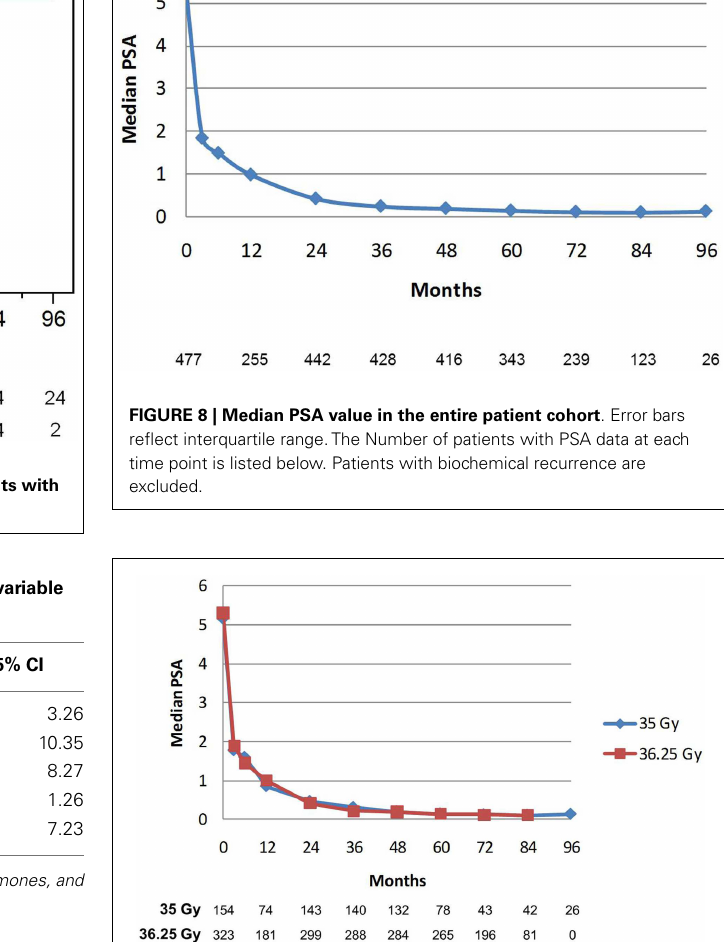
in increased toxicity without yielding improvement in